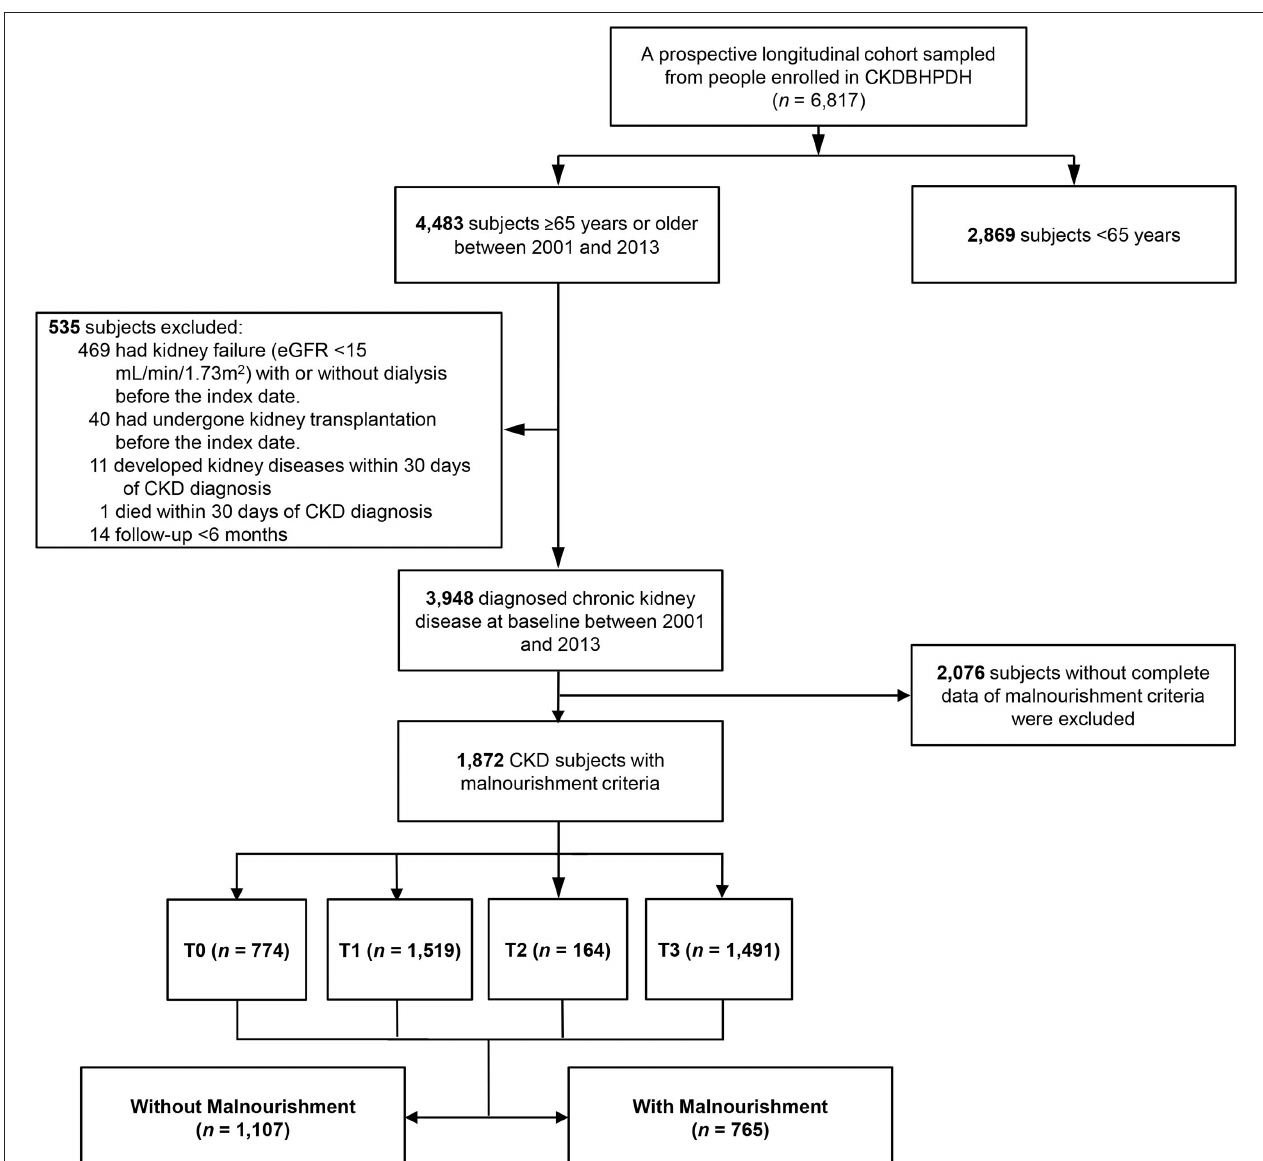
FIGURE 1 | Flow chart of subject selection for the study cohort. A total of 3,948 older adults with a history of chronic kidney diseases (CKD) was identified in the Chronic Kidney Disease division of the Bureau of Health Promotion, Ministry of Health and Welfare (CKDBHPDH) from 2001 to 2013. Among the 3,948 patients, 2,076 patients without complete data of malnourishment criteria were excluded. 1,872 participants whose eGFR trajectory patterns were analyzed and were stratified by the absence or presence of malnourishment, and 765 patients were identified and categorized as having malnourishment. T0–T3: eGFR trajectory